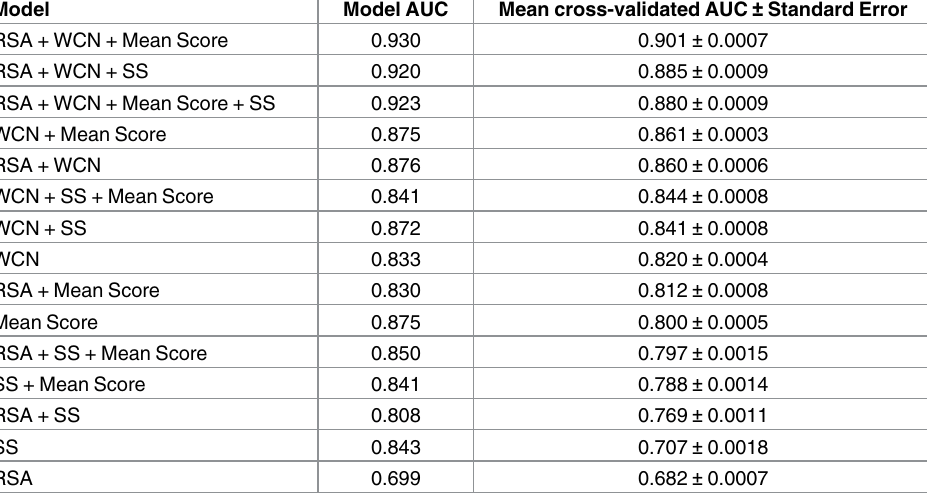
Table 1. Summary of AUC values for logistic regression models. The structural propertiesanalyzedare RSA, WCN, secondary structure (SS), and mean score. Model AUC indicatesthe AUC resultingfrom fitting a logistic regressionto the entire dataset, and mean cross-validatedAUC indicatesthe averagedAUC calcu- lated from repeated10-fold cross-validation. Models are sorted in order of descending